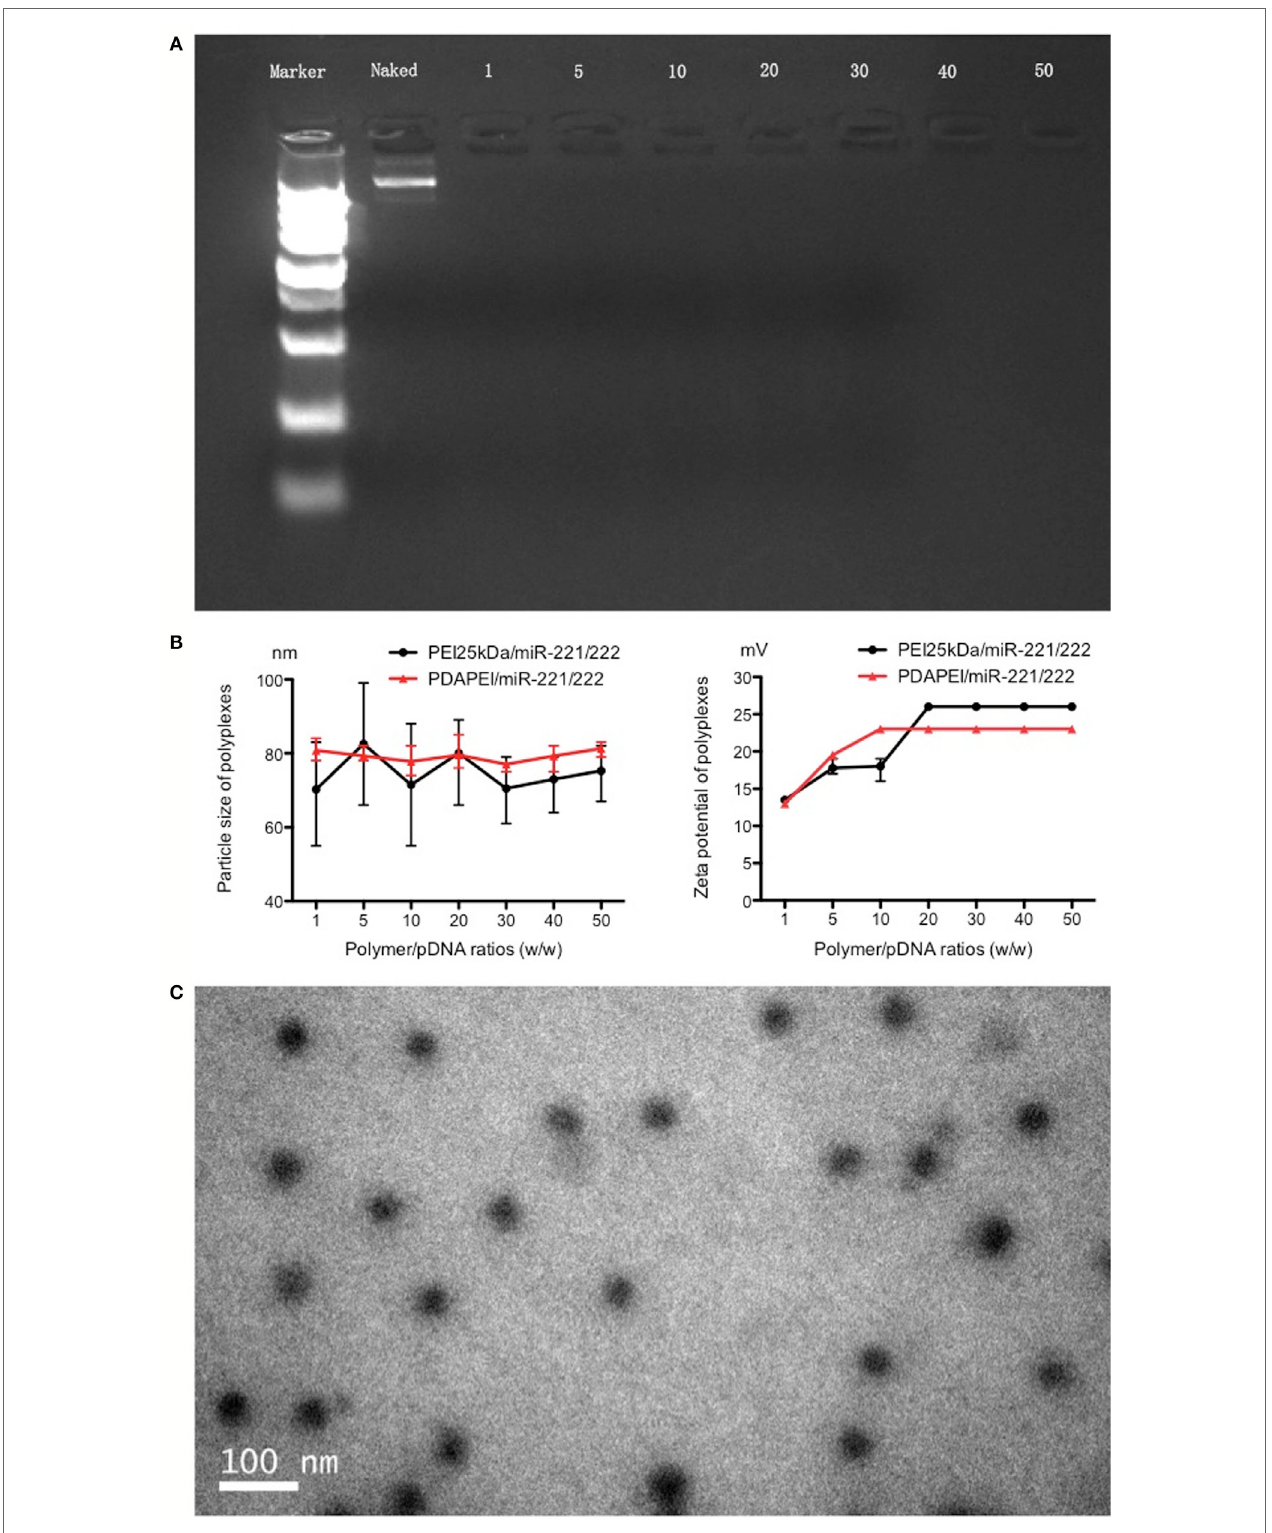
FigUre 2 | characteristics of PDaPei/pDna complexes . (a) Gel electrophoresis indicated that PDAPEI condensed TNF- α shRNA completely at the w/w ratio of 1 or above (w/w = PDAPEI/TNF- α shRNA). (B) Particle size and zeta potential of polymer/DNA complexes (different w/w). (c) Morphology of PDAPEI/pDNA is observed by transmission electron microscopy